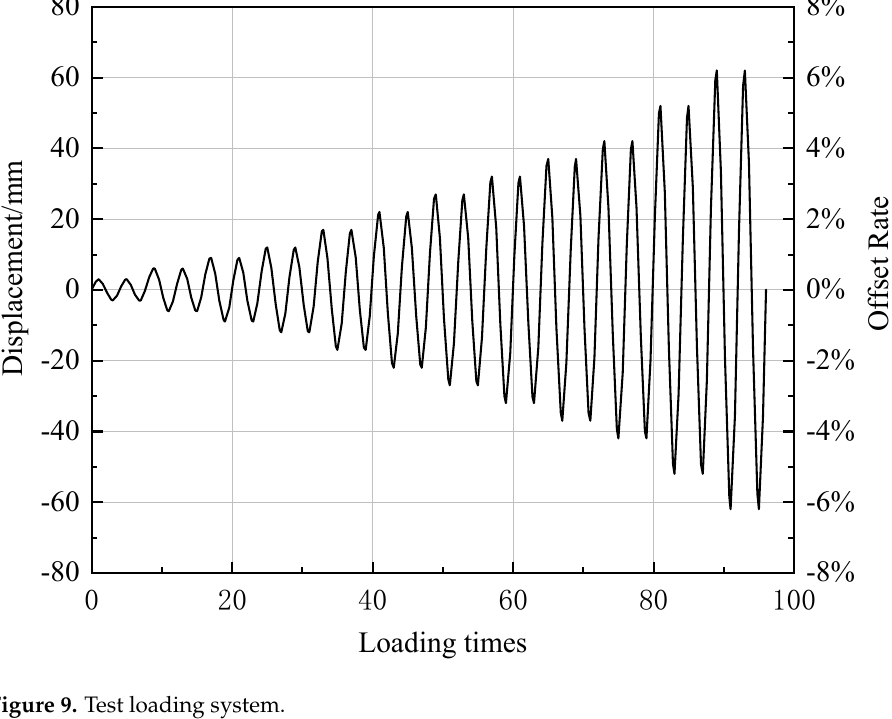
Figure 9. Test loading system.